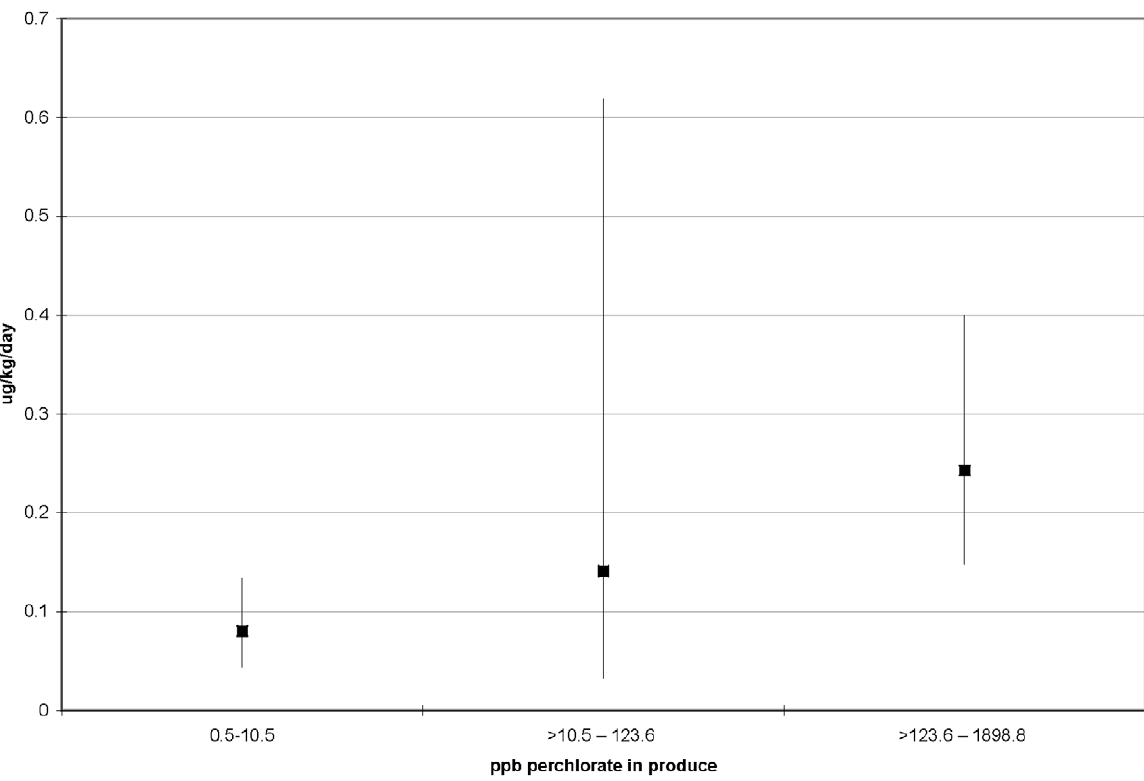
Figure 3. Geometric mean perchlorate dose in urine ( m g/kg of body weight/day) and 95% confidence intervals in study participants by perchlorate concentration in produce for each participant, Imperial County, California, 2009.